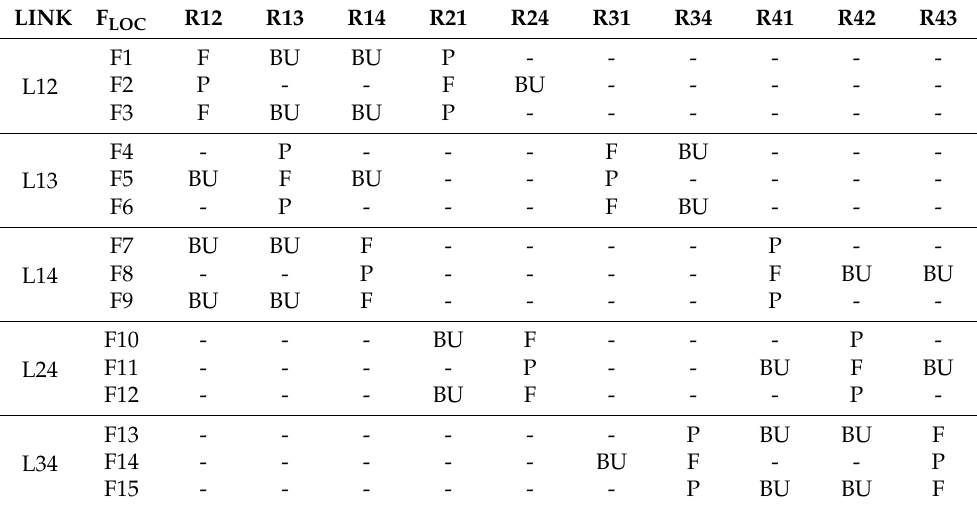
Table 1. Performance of the proposed protection system against different 0 Ω PtP fault cases.